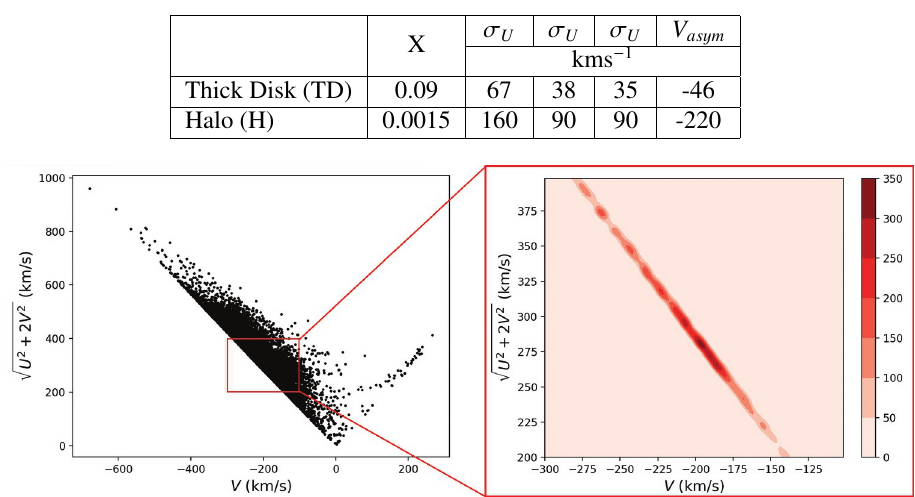
Table 1: Fraction number and characteristics of Gaussian distribution for stars in thick disk and halo.